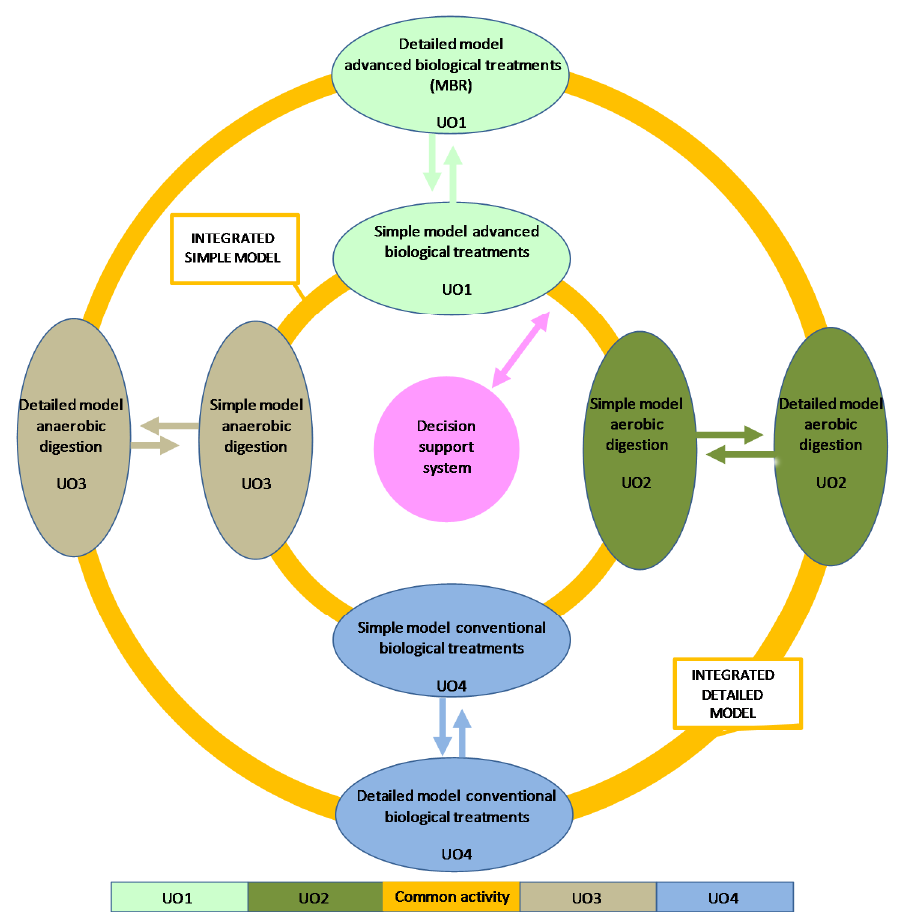
Figure 3. Integrated model layout of the WWTP with indication of the contribution provided by each research unit